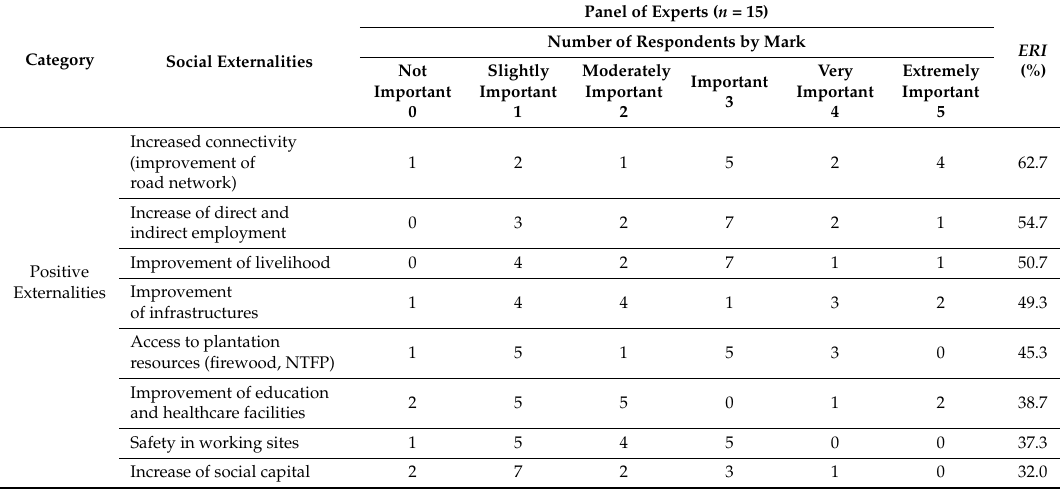
Table A3. Frequency of the Likert scale per externality and relative scores of social externalities according to the experts’